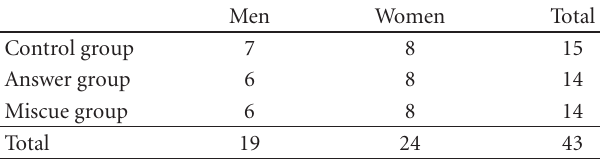
Table 1: Participants’